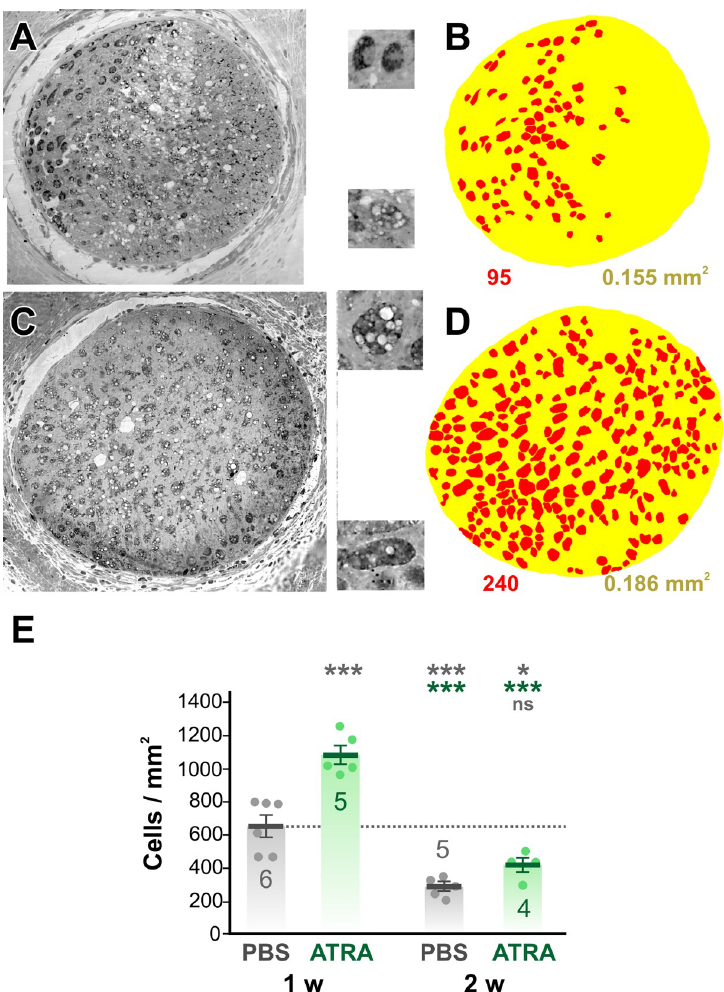
at 1 week after axotomy. A. is a PBS-treated control, C is from an ATRA-treated animal. The insets show enlarged examples of macrophage cell profiles, showing dark staining, granules, and vacuoles. (B and D) Color overlays of the light micrographs, delineating macrophage cell profiles (red) and the nerve itself (yellow). The cell count and nerve area derived from these overlays are shown below. (E) Scatterplots of cell density showing mean ± SEM. Treatments are PBS or ATRA, at 1 or 2 weeks after axotomy. Numbers of animals are shown. Asterisks or “ns” above each column indicate the significance when compared to 1 week PBS (row 1, gray), 1 week ATRA (row 2, red), or 2 weeks PBS (row 3, gray) with ANOVA and post-hoc Tukey tests. The macrophage cell density is increased at 1 week after optic nerve injury by ATRA treatment. By the second week the cell density has decreased, with ATRA treatment showing no significant difference from PBS